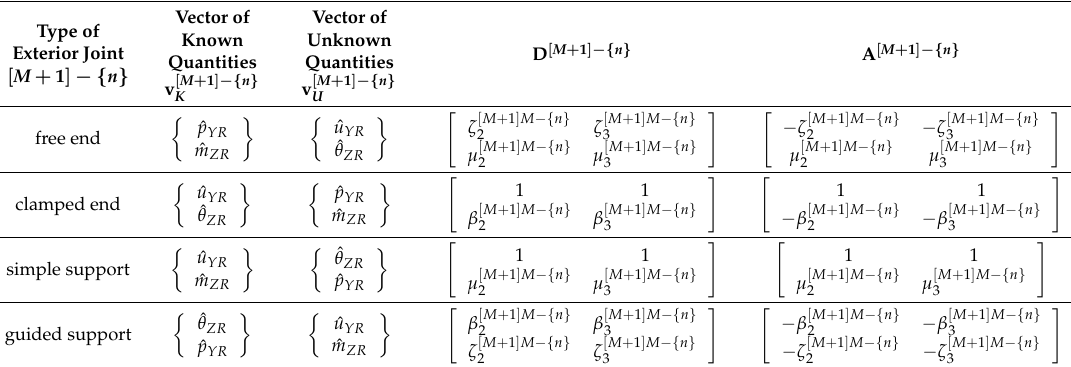
Table 2. The known and unknown quantities of four types of right exterior joint [ M + 1 ] − { n } as well as the matrices and vector for computing the scattering matrix and the source